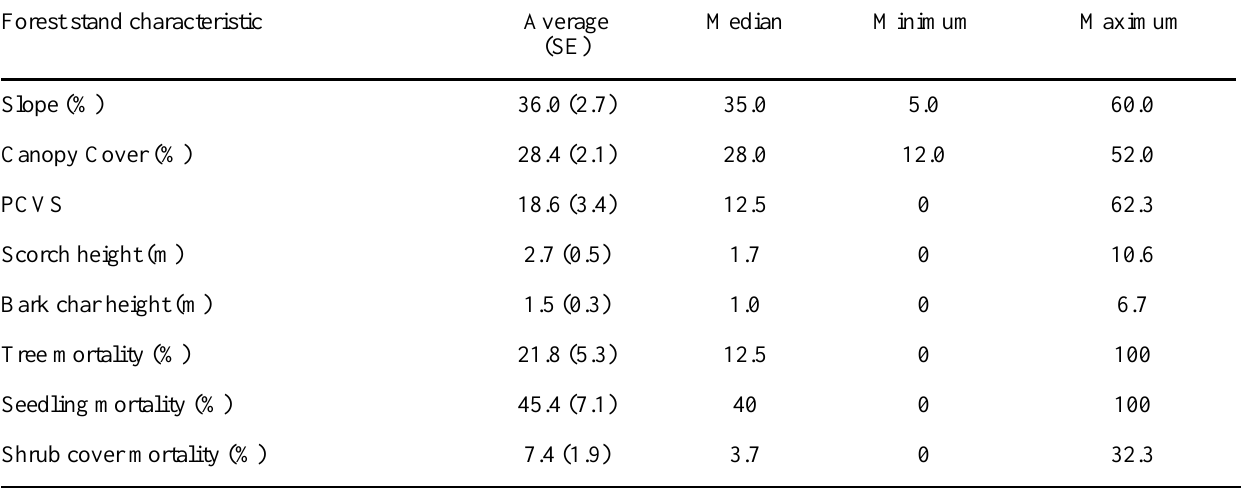
Table 1. Summary of fire effects after a 2003 wildfire in a Jeffrey pine-mixed conifer forest in the Sierra San Pedro Martir (SSPM), northwestern Mexico ( n =27 plots). SE, one standard error of the mean; PCVS, percent crown volume scorched. Data from